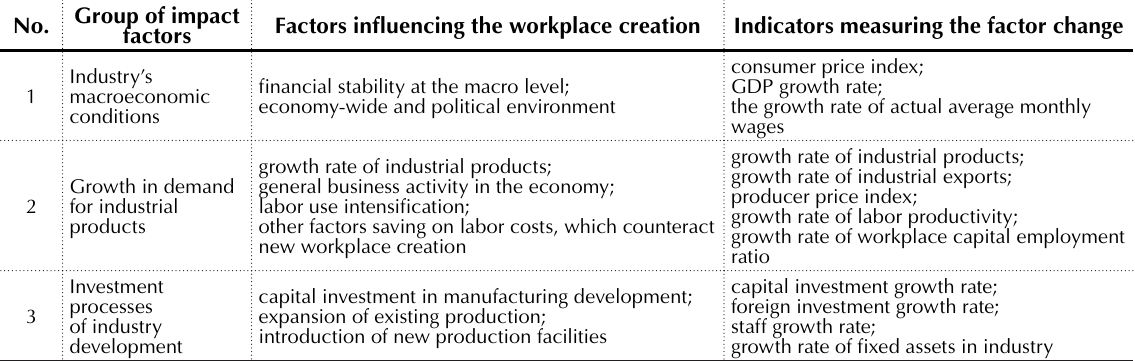
Table 1. Systematization of factors ( X workplaces ( Y i